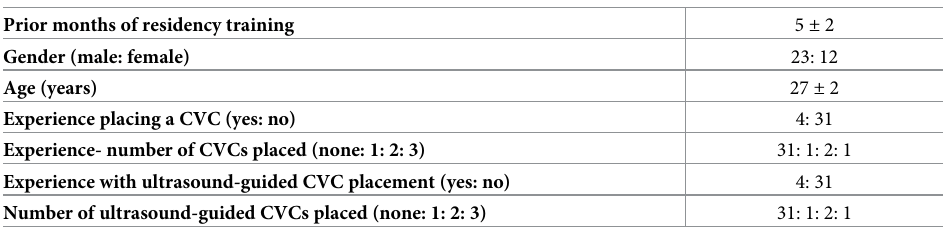
Table 1. Demographic data of